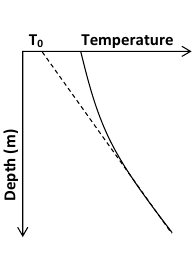
Figure 2. Schematic diagram of borehole temperature–depth pro- files showing ground surface temperature (a) warming and (b) cool- ing. Dashed and Solid line indicates the steady-state and mea- sured temperature respectively. T 0 represent ground temperature at steady-state